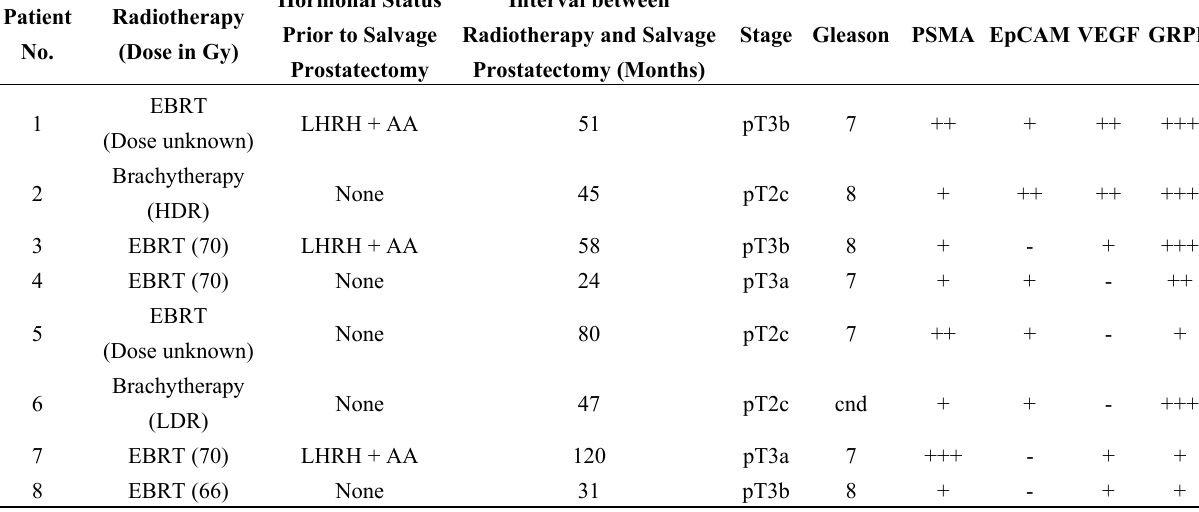
Table 1. Gleason sum scores, therapy characteristics and staining intensities of the antibodies in the salvage prostatectomy